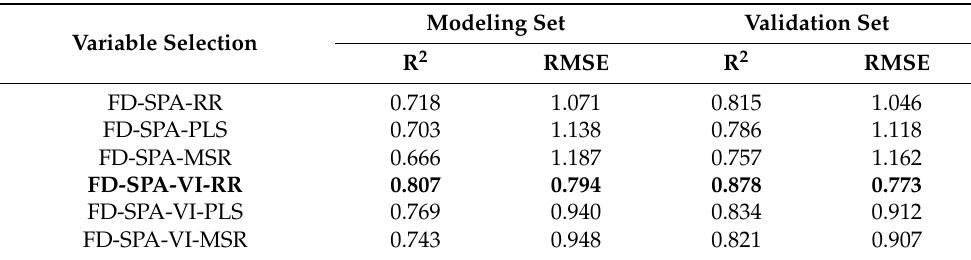
Table 5. Comparison of modeling set and validation set The total number of samples for LAI was 120, 60 modeling sets and 60 validation